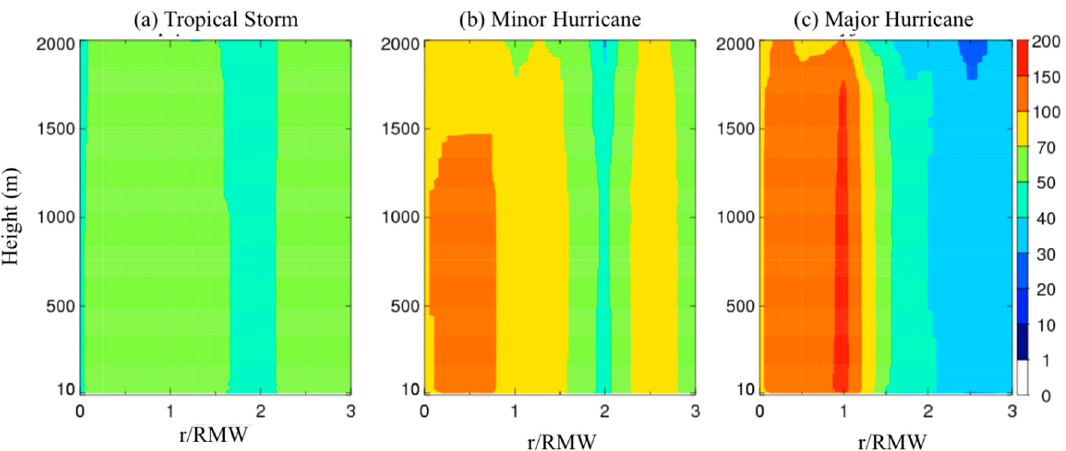
Figure 2. Distribution of data counts in the normalized-radial and vertical plane for ( a ) tropical storms, ( b ) minor hurricanes, and ( c ) major hurricanes.